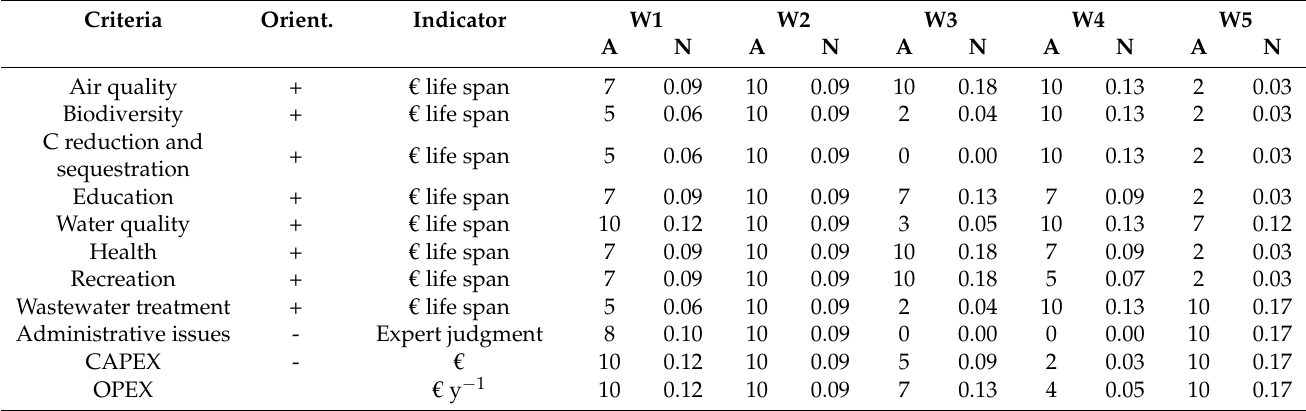
Table 1. Criteria (with orientation and indicators) and weights defined for the sensitivity analysis, expressed in absolute (A: scale 0–10) and normalized (N: scale 0–1)